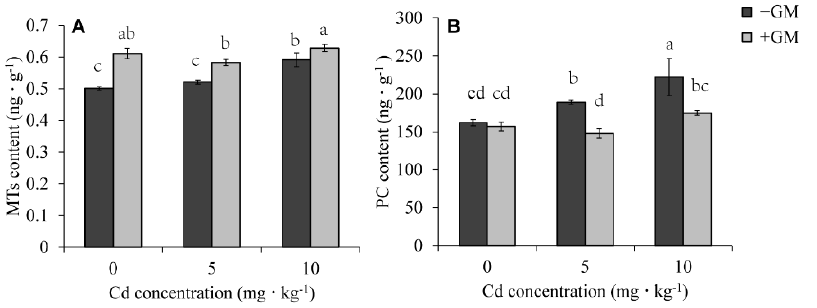
Figure 6. Effects of AMF on MTs ( A ) and PCs ( B ) content under different Cd concentrations. Values are the means ± standard deviation (SD) ( n = 3). Different letters in the same column indicate statistically significant differences ( p < 0.05).